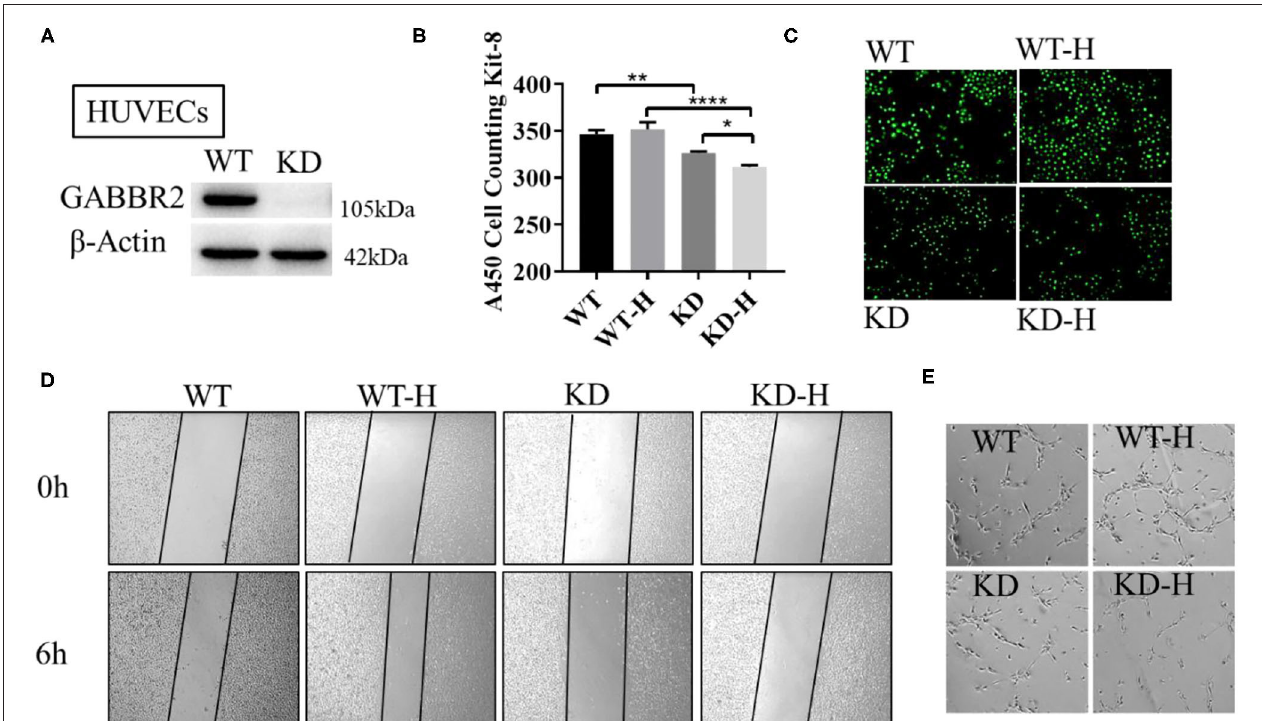
FIGURE 2 | Effect of gamma-aminobutyric acid type B receptor subunit 2 (GABBR2) knockdown on the proliferation, migration, and angiogenesis of human umbilical vein endothelial cells (HUVECs). (A) Downregulation of GABBR2 in HUVECs by lentivirus transfection. (B) Cellular proliferation changes induced by 6h of hypoxic treatment in normal and GABBR2-downregulated HUVECs. (C) EdU staining induced by 6h of hypoxic treatment in normal and GABBR2-downregulated HUVECs. (D) Wound healing distance changes induced by 6h of hypoxic treatment in normal and GABBR2-downregulated HUVECs. (E) Tube-like construction formation induced by 6h of hypoxic treatment in normal and GABBR2 downregulated HUVECs. * p < 0.05; ** p < 0.01; **** p < 0.0001.